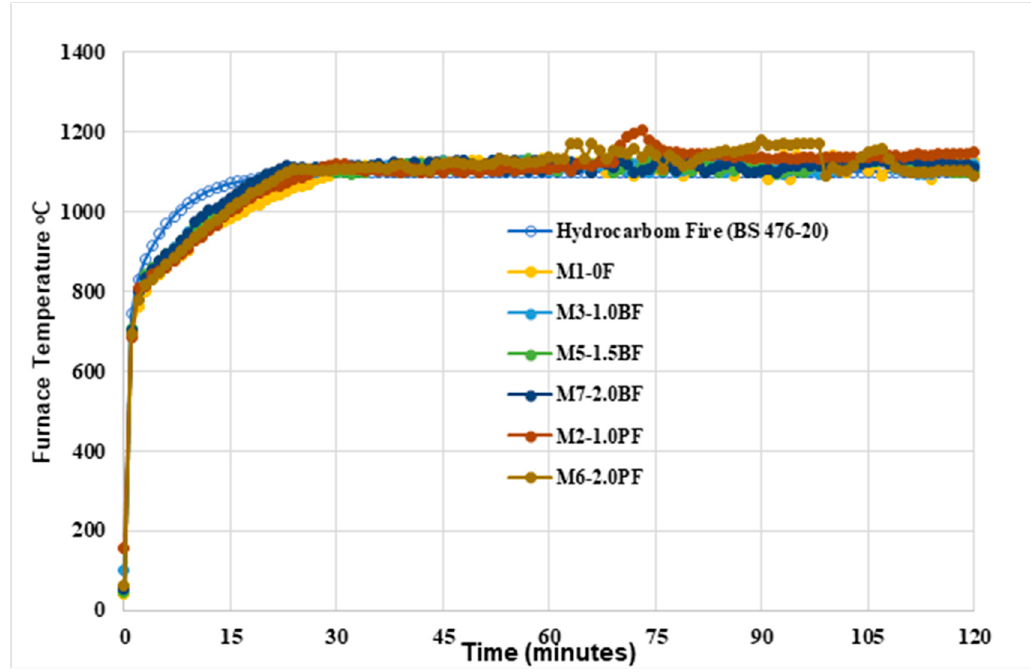
Figure 6. Furnace temperature during the tests of different slabs and standard fire curve for hydrocarbon fire according to BS 476-20: 1987.